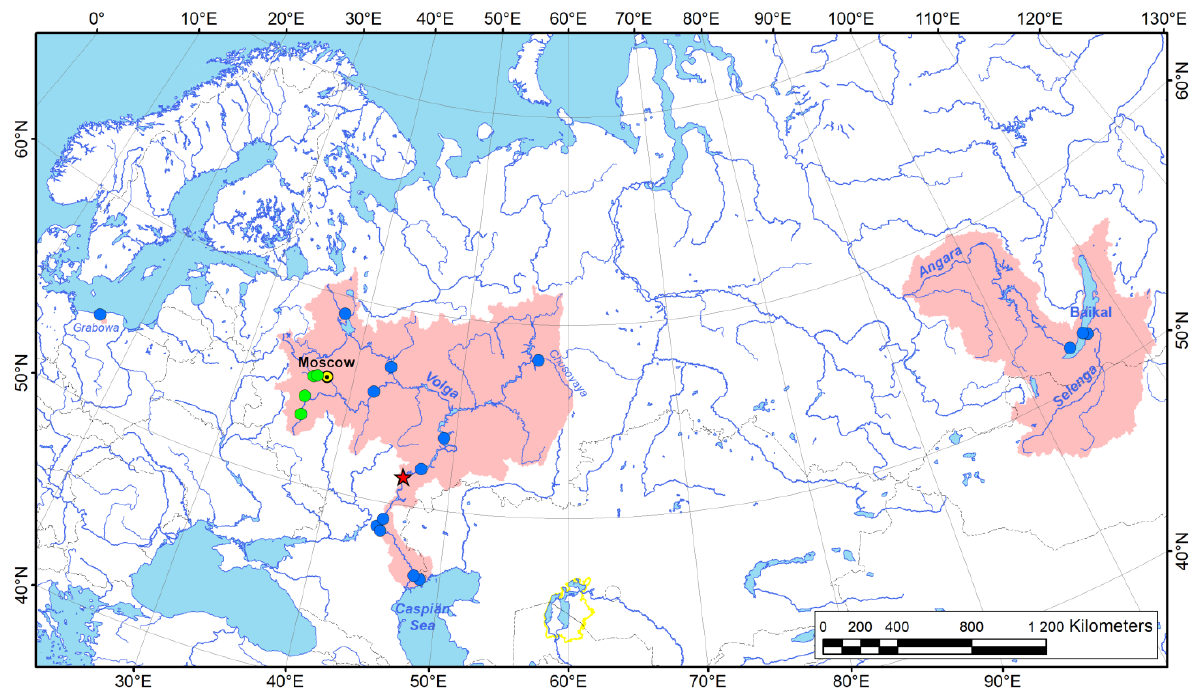
Figure 1. Distribution and occurrences of Acipenserobdella volgensis (Zykoff, 1904). The light red areas indicate the range of the species based on freshwater basin boundaries. The red star indicates the type locality of the species; the green circles indicate the localities of specimens that were collected under this study; and the blue circles indicate published records (raw occurrence data is presented in Table S2). The map was created using ESRI ArcGIS 10 software (www.esri.com/arcgisaccessed on 19 August 2022).